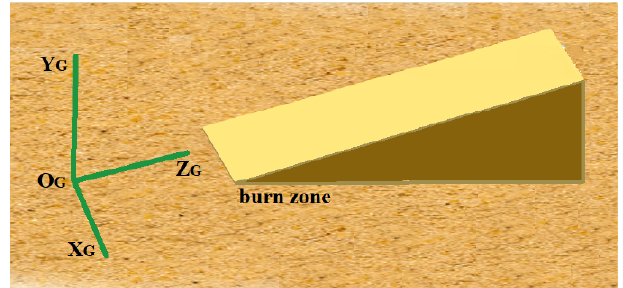
Figure 8. Position and orientation of the global